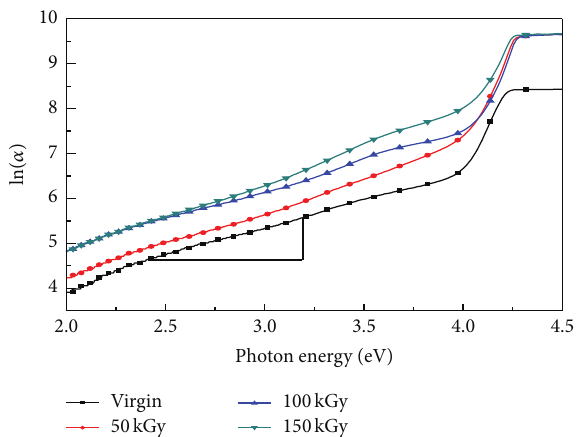
Figure 3: Urbach energy for virgin and electron irradiated silk fibroin films.